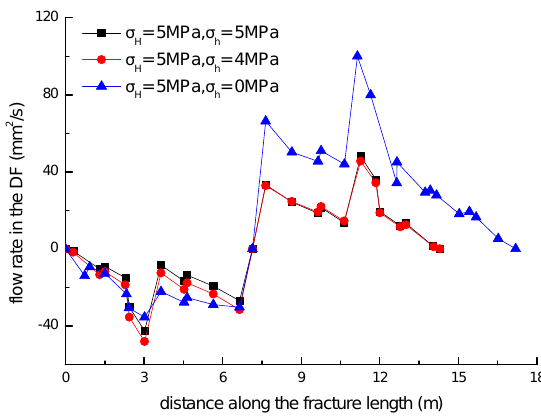
Figure 14. The flow rate curves of the DF along the fracture length at different levels of remote horizontal principle stress difference. The distance in the x -axis is along the direction from the lower part to the upper part of the